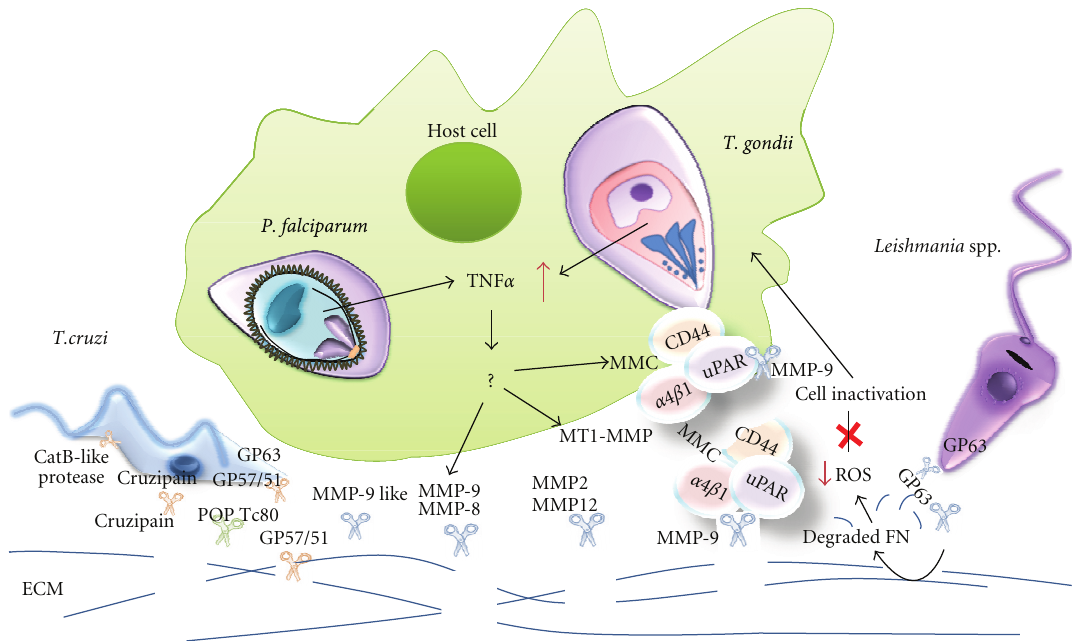
Figure 2: Intracellular parasite proteases. CPs: cysteine proteases, pink scissors; SPs: serine proteases, green scissors; MMPs: matrix metalloproteases, blue scissors; ECM extracellular matrix; POP: prolyl oligopeptidase; CatB: cathepsin B; MMC: migratory molecular complex; ROS: reactive oxygen